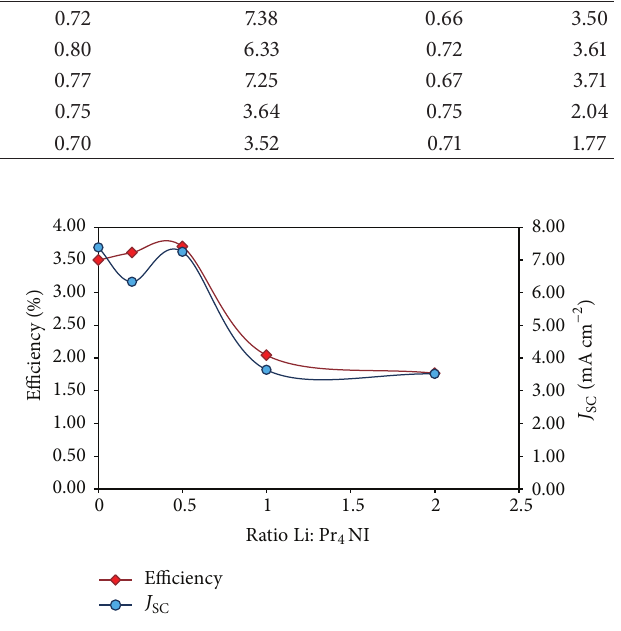
Table 4: The performance parameters of DSSCs with different gel polymer electrolytes. Electrolyte samples